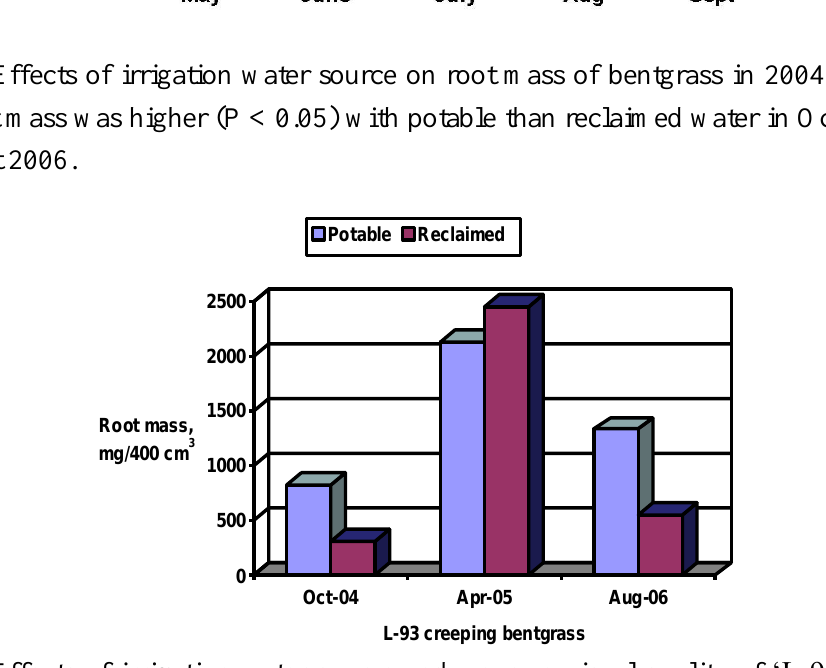
Figure 5. Effects of irrigation water source and wear on visual quality of „L-93‟ creeping bentgrass in 2004. 9 = highest and 0 = lowest quality. Wear was applied weekly in July and September. Bars within each month followed by different letters are significantly different at 0.05 level of probability. NS = Not